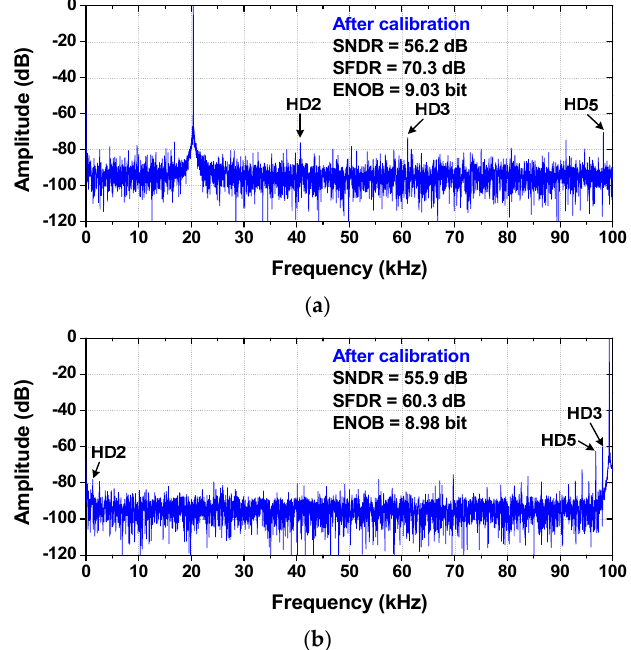
Figure 23. Measured output spectra of the ADC at ( a ) f IN = 20.35 kHz, ( b ) f IN = 99.35 kHz. f S = 200 kS/s.